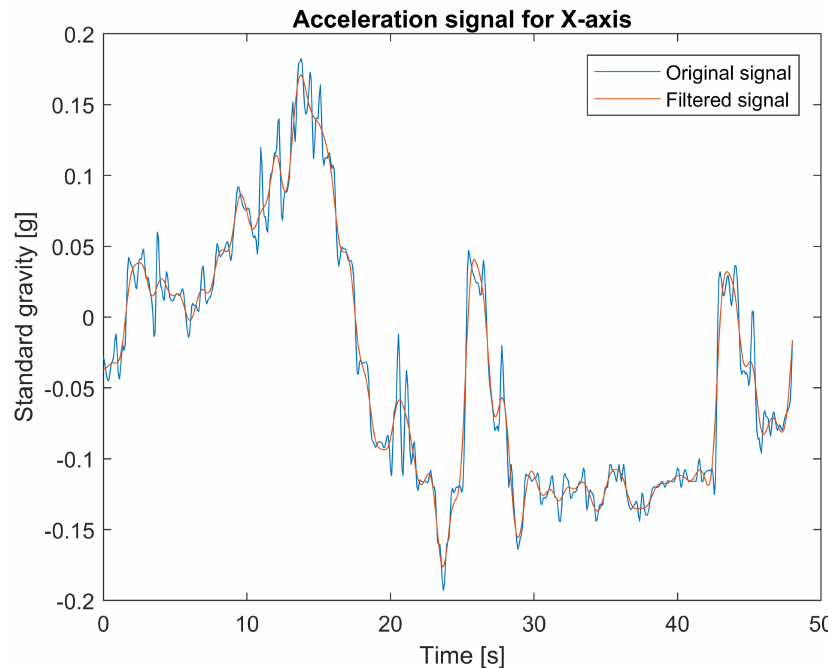
Figure 3. Original and filtered acceleration signal for x -axis.